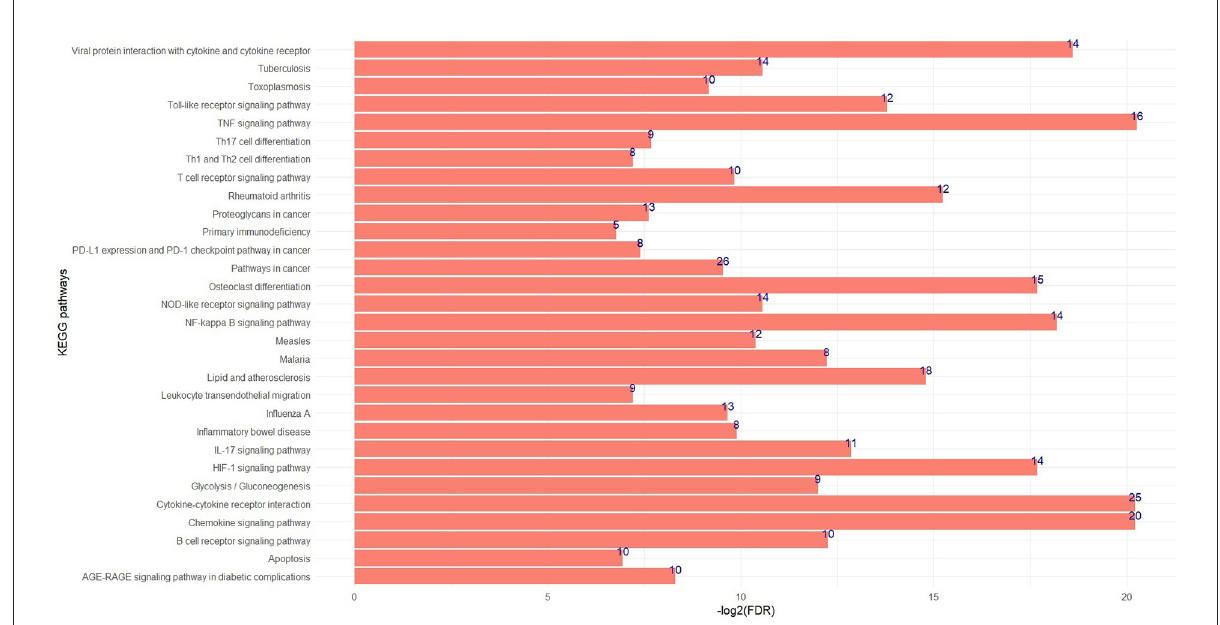
FIGURE4 The top significant KEGG pathways in the sienna3 module. The x and y axes indicate –log2 (FDR) and KEGG pathways, respectively. The numbers indicate number of genes enriched by each pathway.